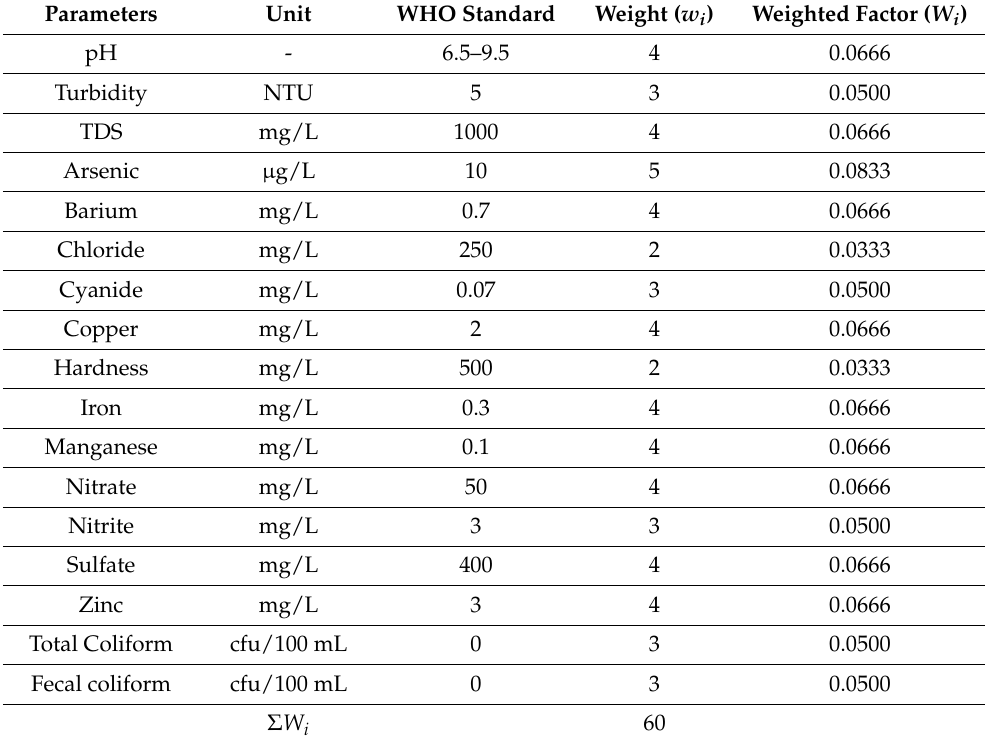
Table 3. Drinking water quality input parameters, their WHO standard values, and weighting factors.